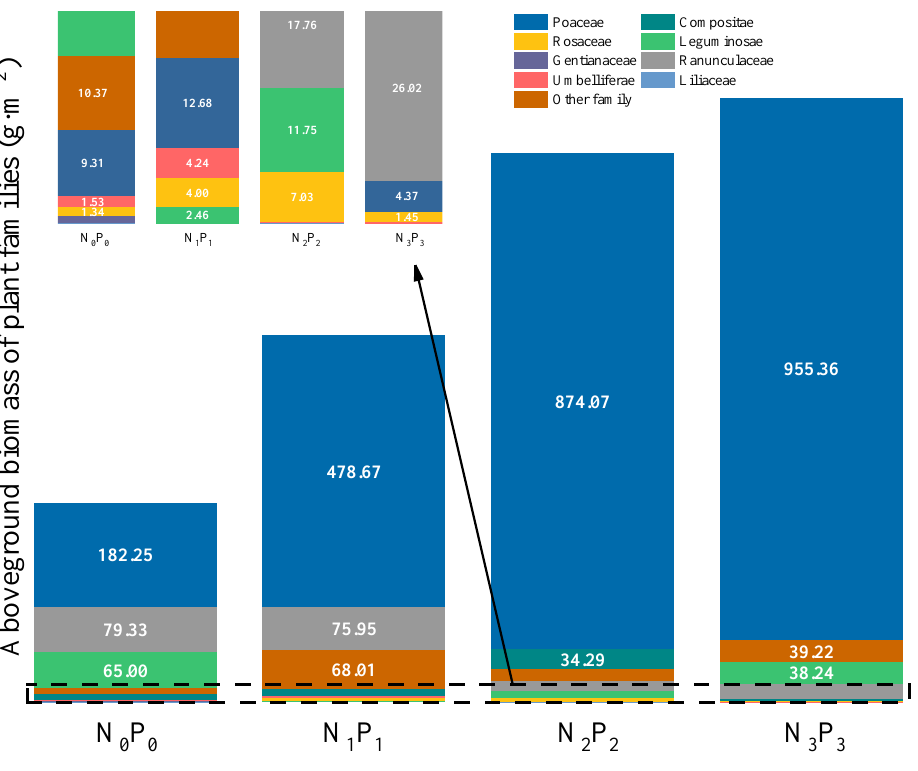
Figure 7. Aboveground biomass of plant families in the community among NP addition treatments.